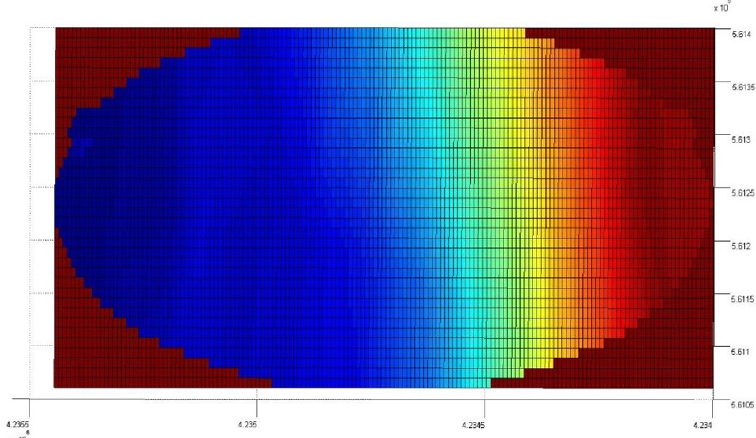
dimensional plane view of the ellipsoidal bathymetric subdomain.